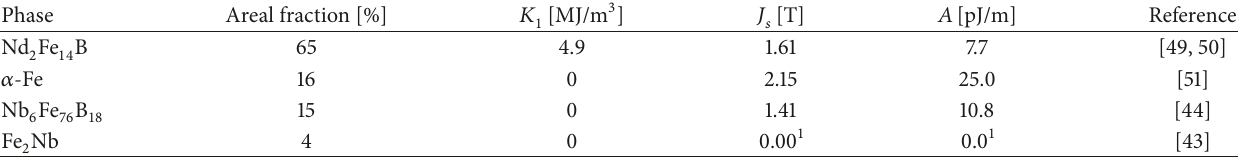
Table 2: Areal fraction and magnetic properties of the four identified granular phases used in the micromagnetic simulations. Phase